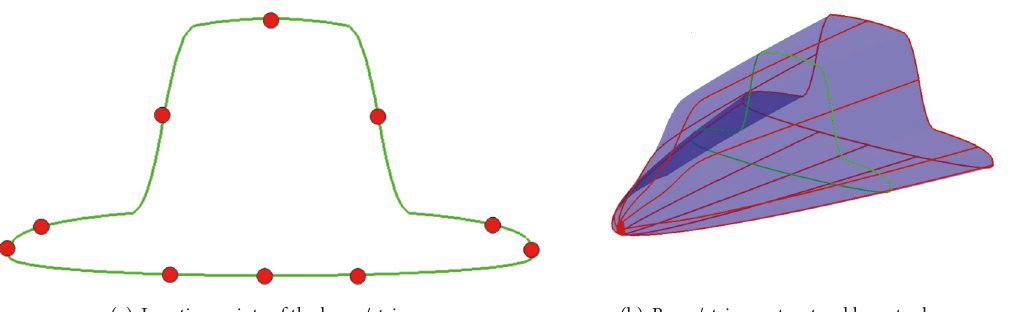
Figure 3: The beam/stringer structural layout scheme of a hypersonic aircraft.